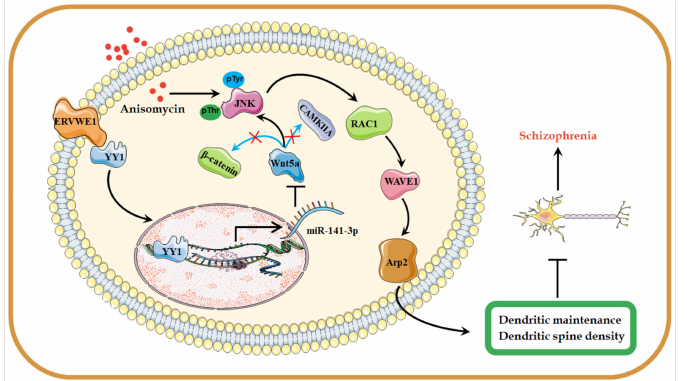
Figure 8. A possible hypothesis that ERVWE1 reduces dendritic spine density and alters dendritic spine morphology. The elevated ERVWE1 increased the expression of miR-141-3p through binding with TF YY1 and inhibited the Wnt/JNK non-canonical signaling pathway, then leading to impaired neuronal morphology and reduced dendritic spine density in rat hippocampal neurons, which played a critical role in the etiopathogenesis of